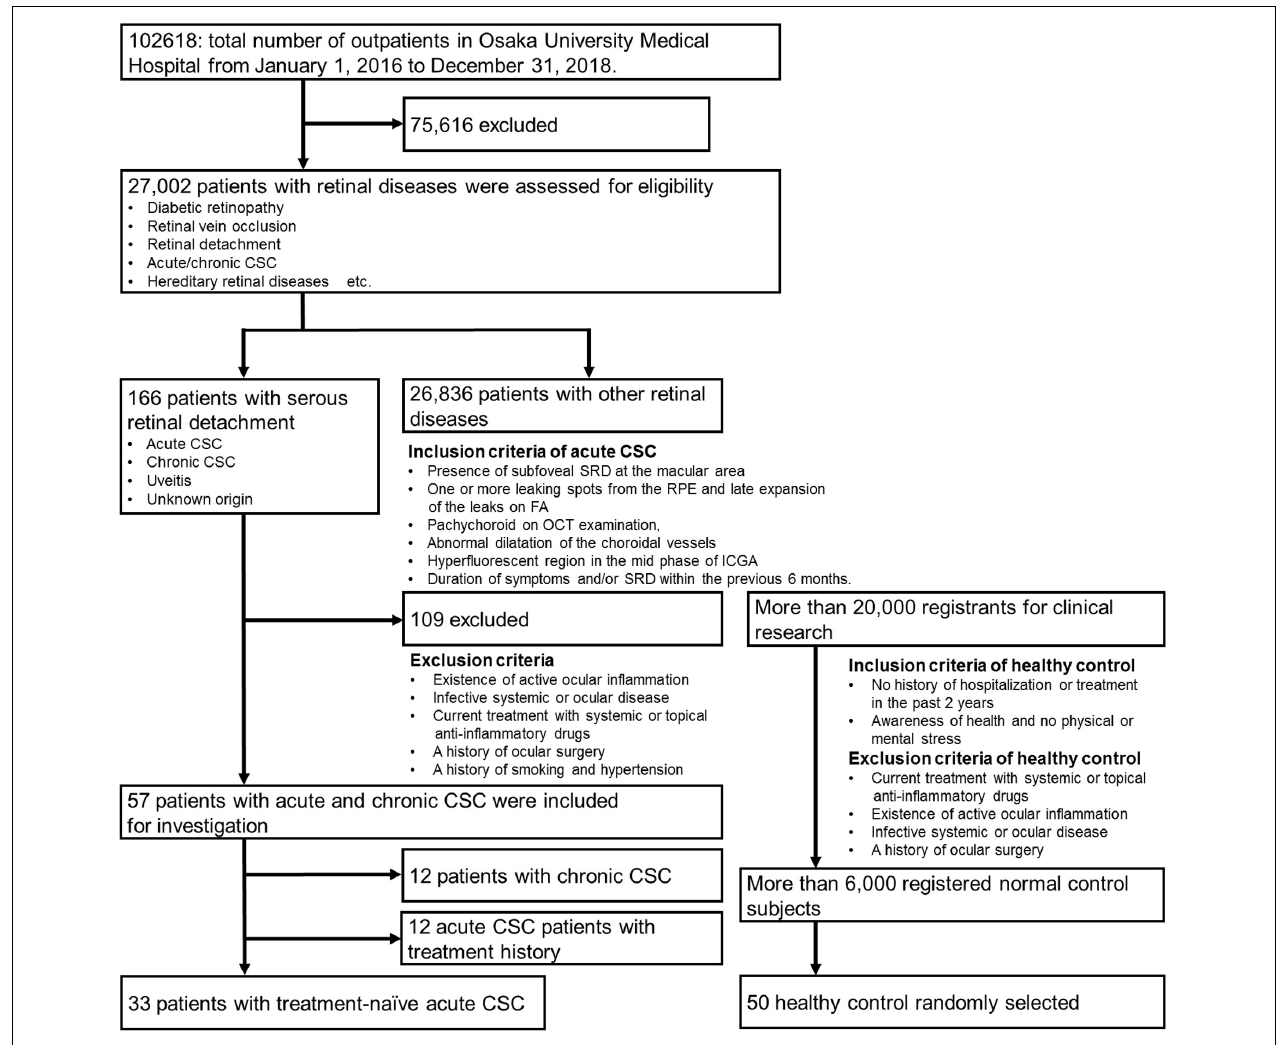
FIGURE 1 | Flow diagram of patient enrollment and inclusion